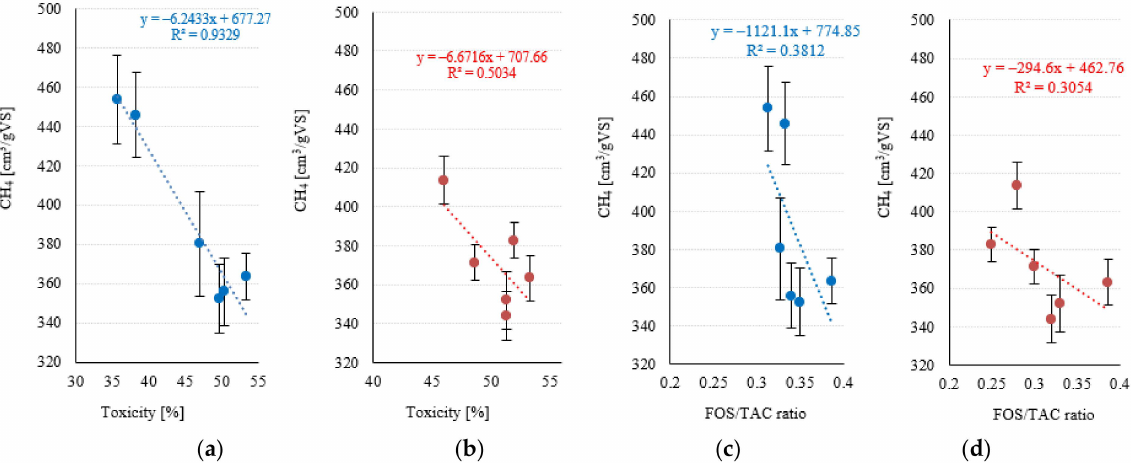
Figure 11. Correlations between toxicity and methane levels ( a ) series 1, ( b ) series 2; FOS/TAC ratio and methane levels ( c ) series 1, ( d ) series